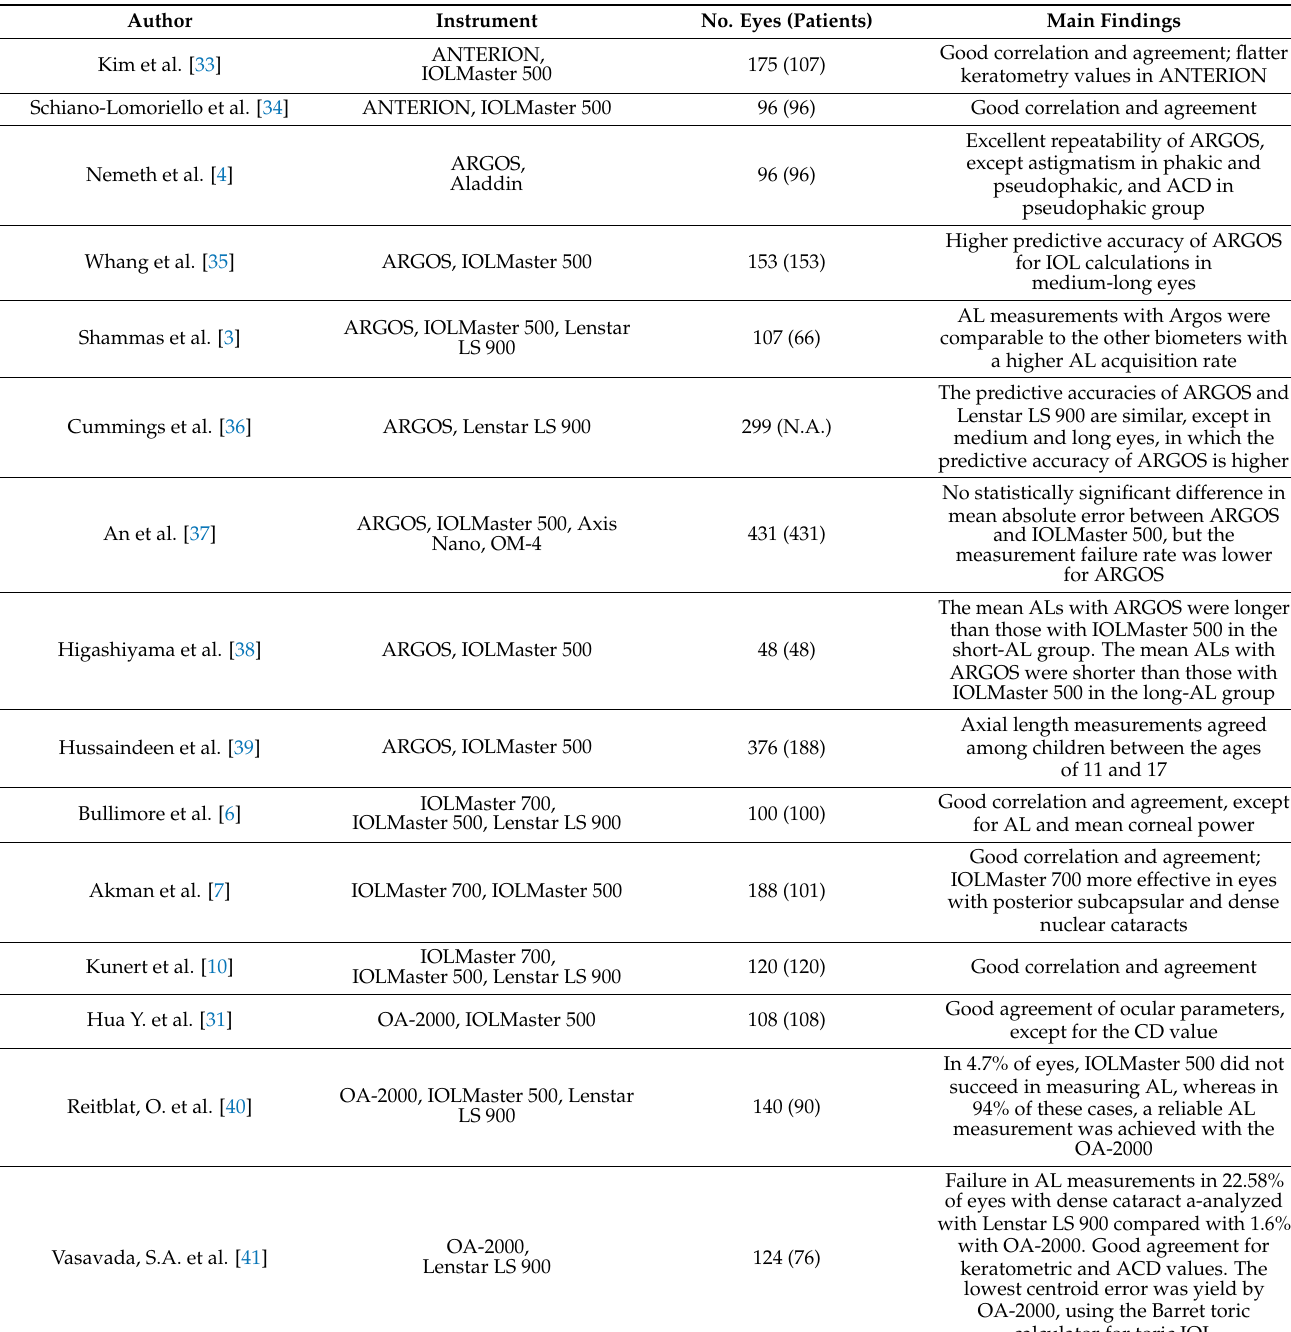
Table 1. Summary of the studies comparing Swept-Source-OCT (SS-OCT) Biometers and Partial Coherence Interferometry (PCI)